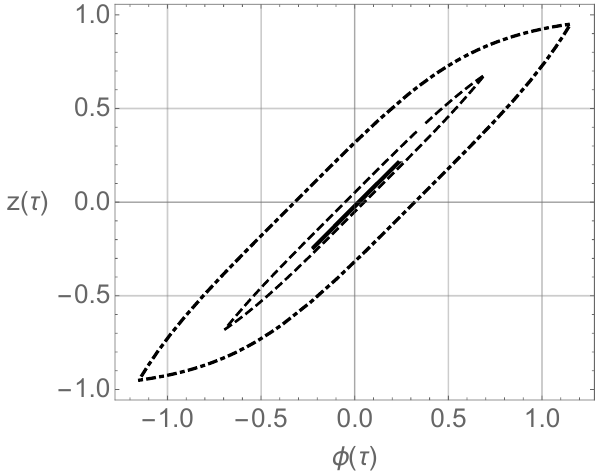
Figure 15. Hysteresis loop in coordinates ( ϕ ( t ) , z ( t )) at K = 5 (continuous line), K = 15 (dashed line), K = 25 (dash-dotted line), ω = 1.2, Ω = 5, and σ = 1.5. Parameters of the Bouc–Wen model are A = 1, β = 0.1, γ = 0.9, and n = 3.